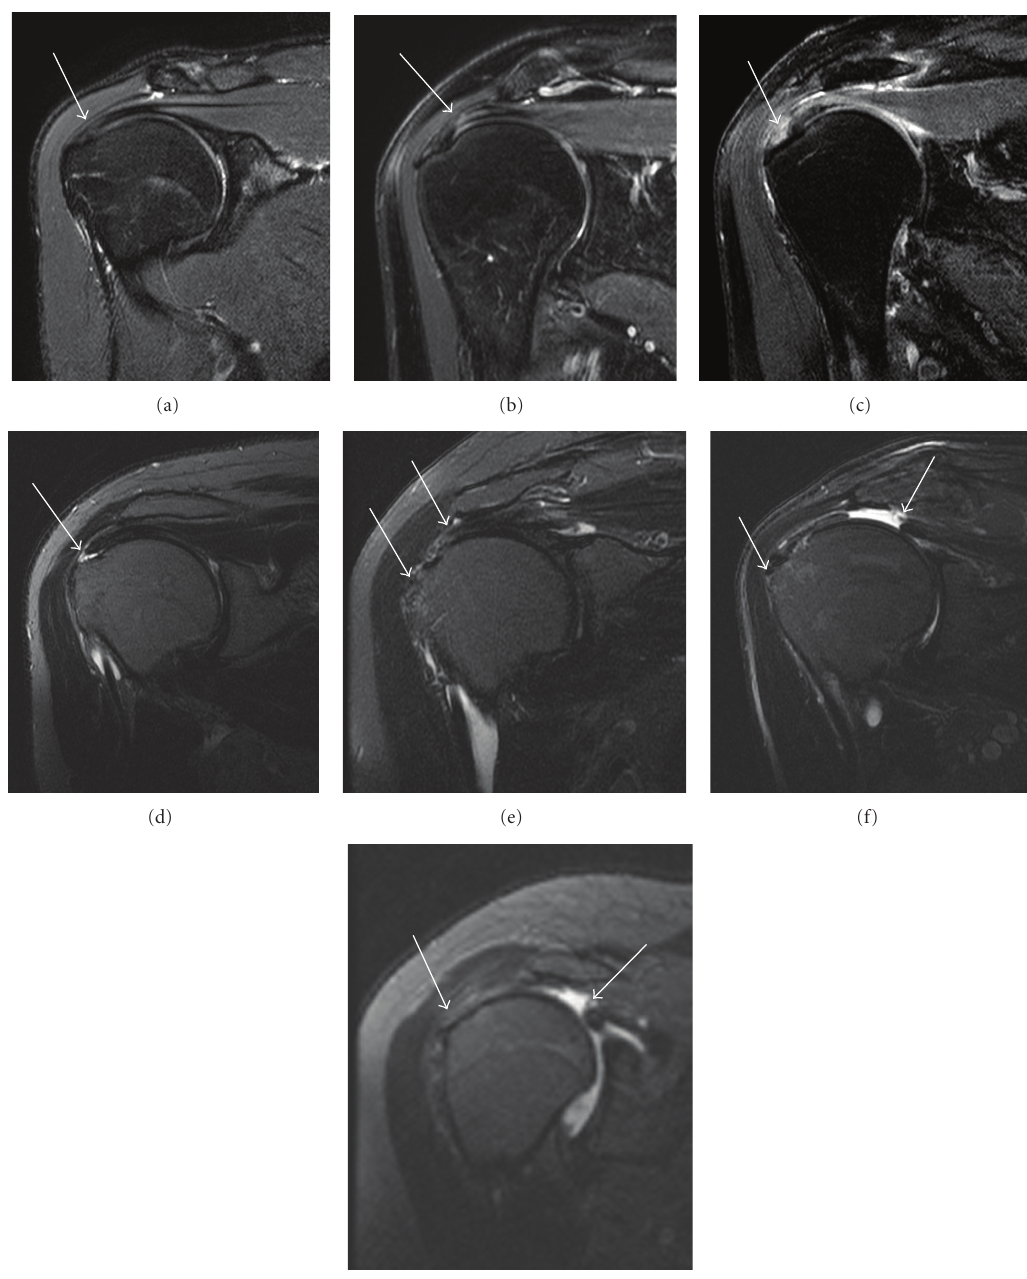
Figure 1: Shoulder MRI grading of rotator cu ff pathology. Seven coronal oblique T2-weighted, fat-suppressed MR images frontal illustrate the grading scheme of rotator cu ff pathology. Arrows show the supraspinatus tendon. (a) Grade 0: normal rotator cu ff tendon; (b) grade 1: tendinosis; (c) grade 2: partial thickness tear; (d) grade 3: small full thickness tear (less than 1 cm); (e) grade 4: medium full thickness tear (between 1 to 3cm); (f) grade 5: large full thickness tear (greater than 3cm but less than 5cm); (g) grade 6: massive rotator cu ff tear (measuring greater than 5cm and/or involving more than two